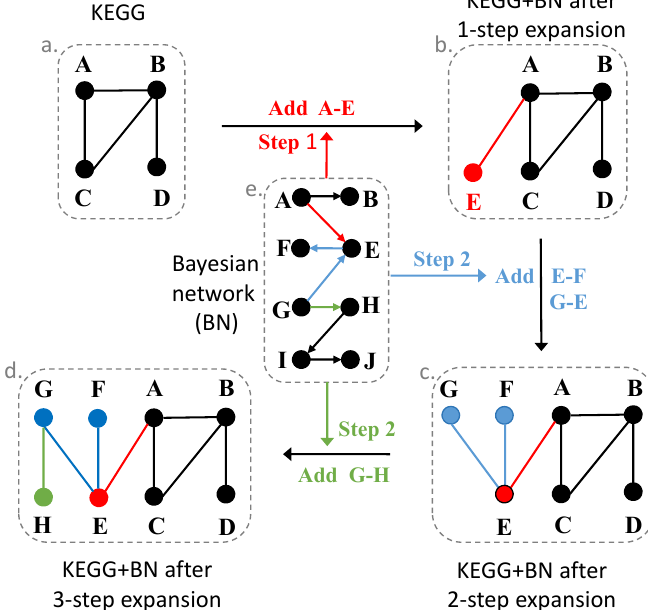
Figure 3. KEGG pathways expansion with the Bayesian network.